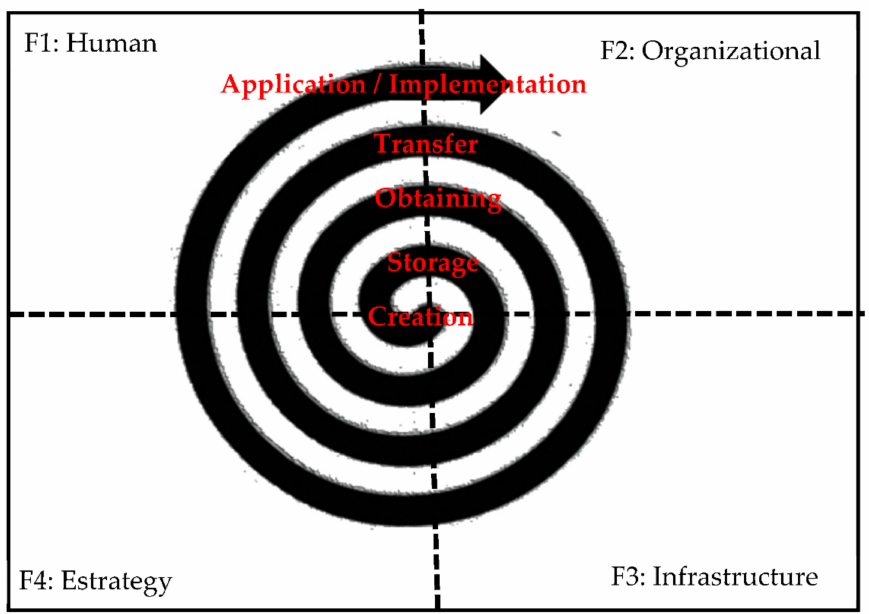
Figure 6. Proposed knowledge and innovation management model. Source: